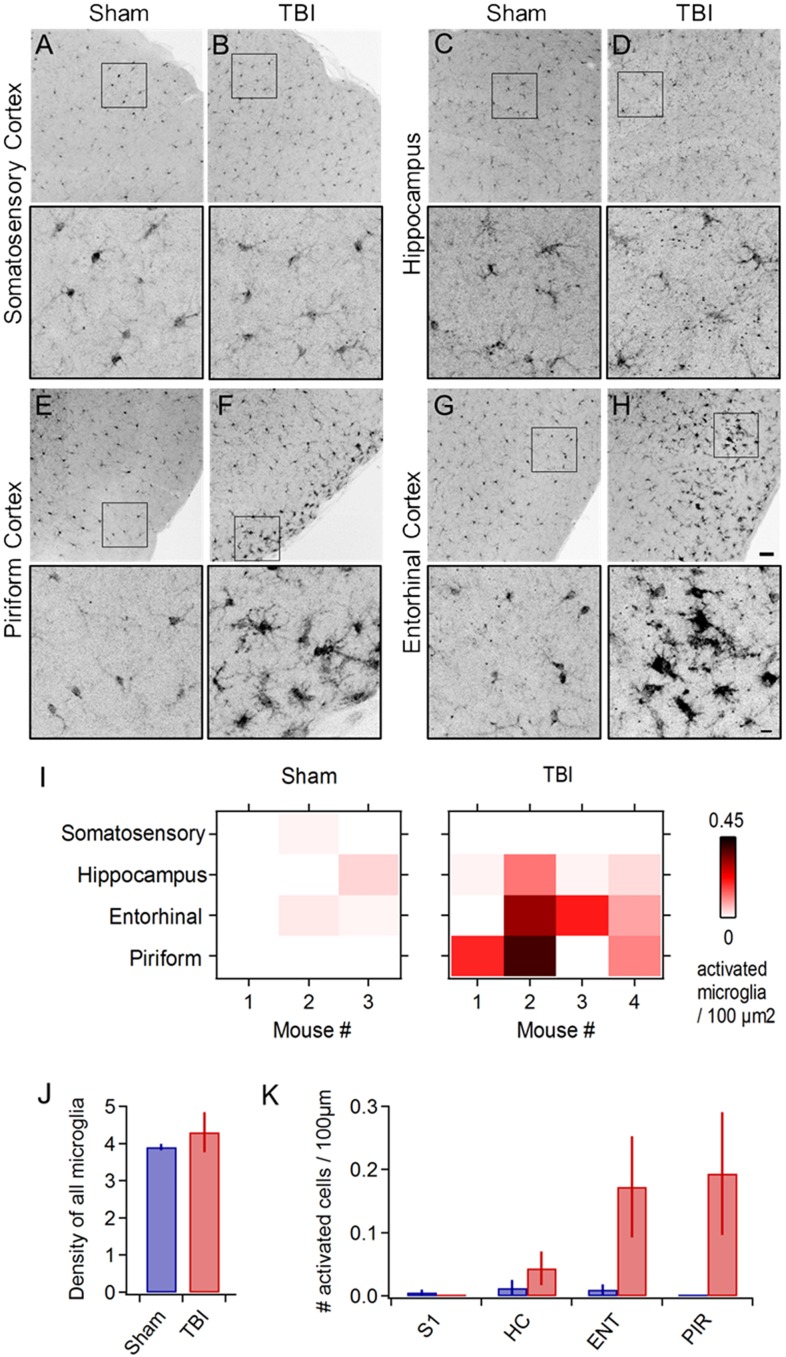
Mild injury leads to microglial activation in lateral inferior temporal lobes. (A–H) Iba1 immunostaining reveals microglial morphology in diverse brain regions at 24 h following repeated mild injury. In most regions, microglia appeared largely similar between sham and TBI mice (A–D), but piriform (E,F) and entorhinal areas (G,H) consistently showed clusters with a swollen appearance characteristic of neuroinflammatory response. Microglia with activated morphology were only infrequently found in sham mice. Scale bars, 50 and 10 μm. (I) Heat maps comparing microglial activation across brain areas in individual animals. (J) Injury did not alter total microglial density, including both activated and non-activated cells [4.252 ± 0.279 vs. 4.575 ± 0.394 microglia/100 μm2 for sham and TBI; p = 0.529; t(6) = –0.668; 2 sample t-test; n = 3 sham, 4 TBI mice]. (K) Piriform and entorhinal areas showed the largest increases in microglial activation (piriform: 0 ± 0 vs. 0.194 ± 0.097 activated microglia/100 μm2 for sham and TBI; entorhinal: 0.010 ± 0.008 vs. 0.173 ± 0.080 activated microglia/100 μm2 for sham and TBI).